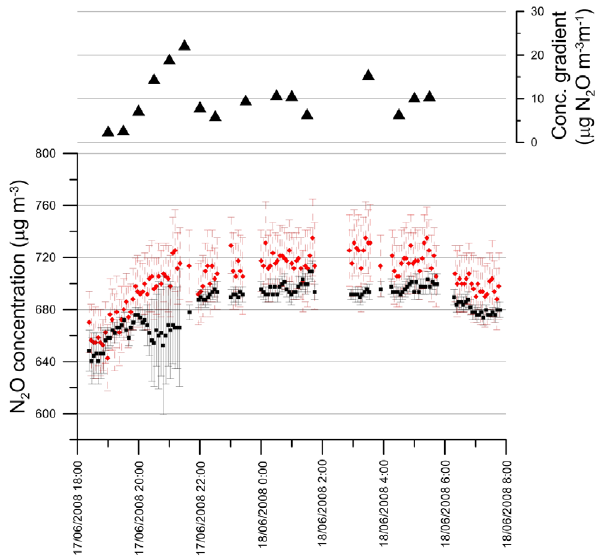
Fig. 10. Temporal variation of the N 2 O concentrations in ambient air (17–18 June 2008) at both heights (0.5m: edge-oriented squares, 2.7m: side-oriented squares) including the statistical errors (random absolute error as columns around the measurement value in both directions) and concentration gradients.